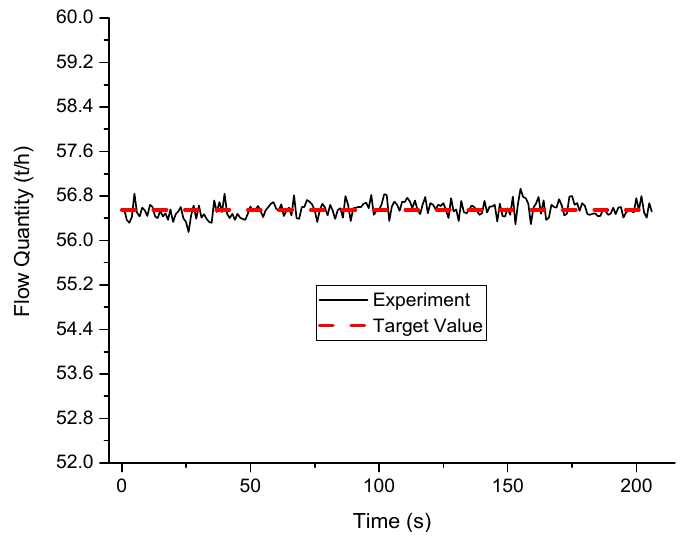
Figure 7. Target value (56.55 t/h) and experimental value of the flow quantity.